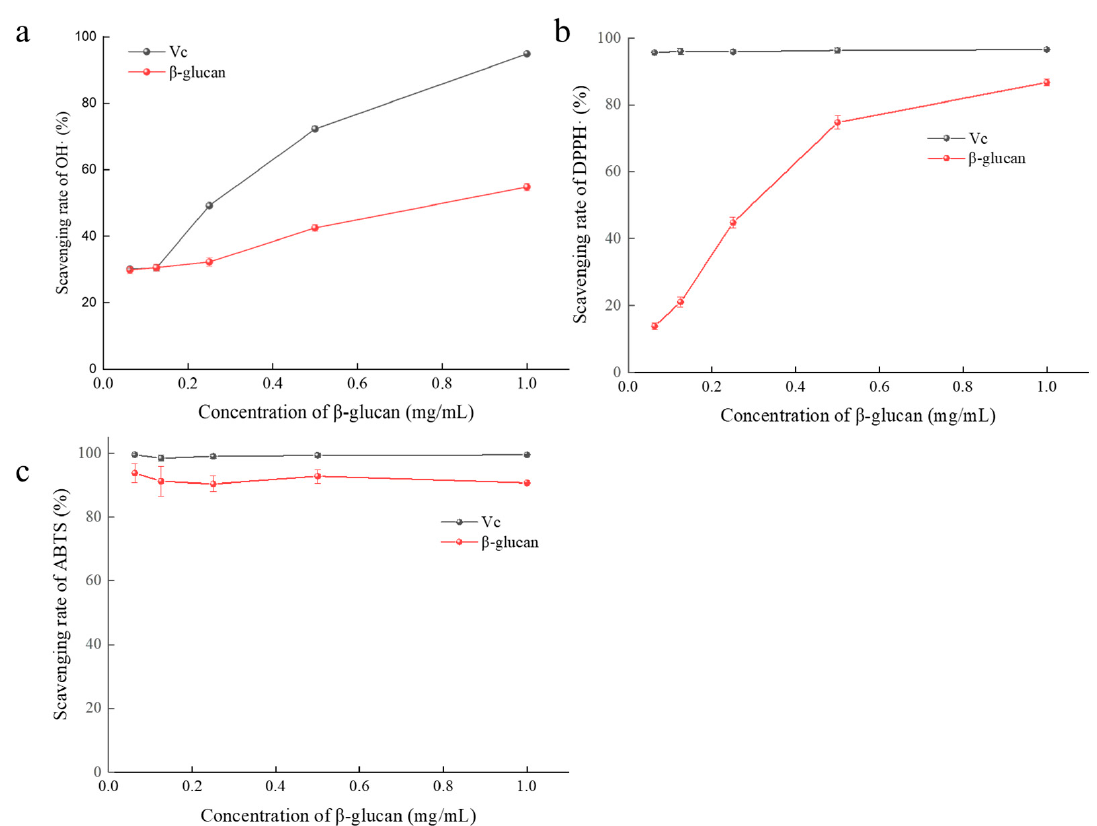
Figure 10. Antioxidant activity of β -glucan. ( a ) The clearance rate of β -glucan on OH·; ( b ) the clearance rate of β -glucan on DPPH·; ( c ) the clearance rate of β -glucan on ABTS·.